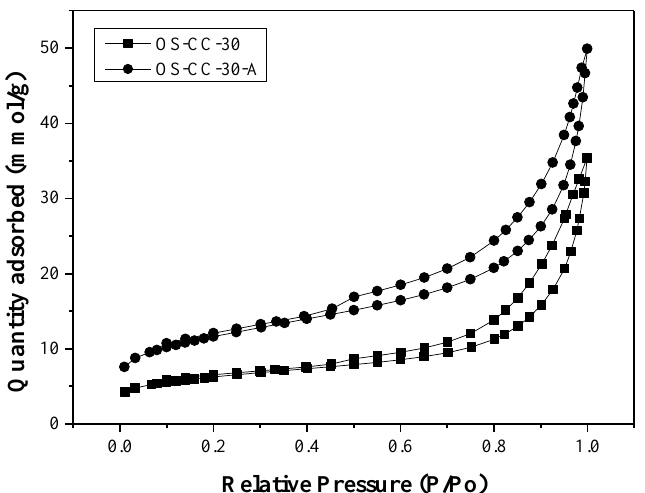
Figure 2. Nitrogen adsorption-desorption isotherms for the CC products (i.e., OS-CC-30 and OS-CC-30-A).